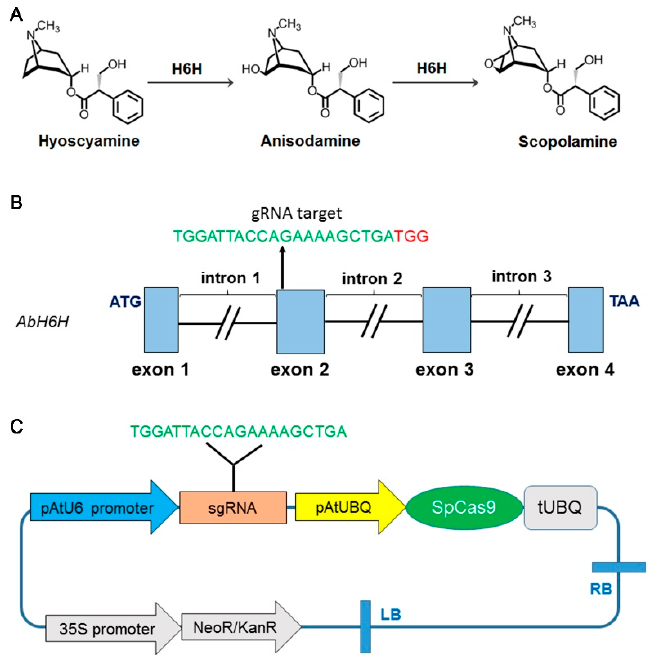
Figure 1. Catalytic function of hyoscyamine 6 β -hydroxylase, genomic structure of AbH6H , and construction of the CRISPR/Cas9 expression vector, named pCas9-H6H. ( A ) Hyoscyamine 6 β - hydroxylase catalyzes the 6 β -hydroxylation of hyoscyamine to produce anisodamine, and subse- quently converts anisodamine into scopolamine through epoxidation. ( B ) Genomic structure of AbH6H and the CRISPR/Cas9 target site in exon 2. The target region is shown in green letters followed by a red protospacer-adjacent motif (PAM), and black breaks between the exons indicate introns; ( C ) CRISPR/Cas9 expression vector construction. The sgRNA was driven by the Arabidopsis thaliana U6 promoter (pAtU6) with kanamycin resistance.